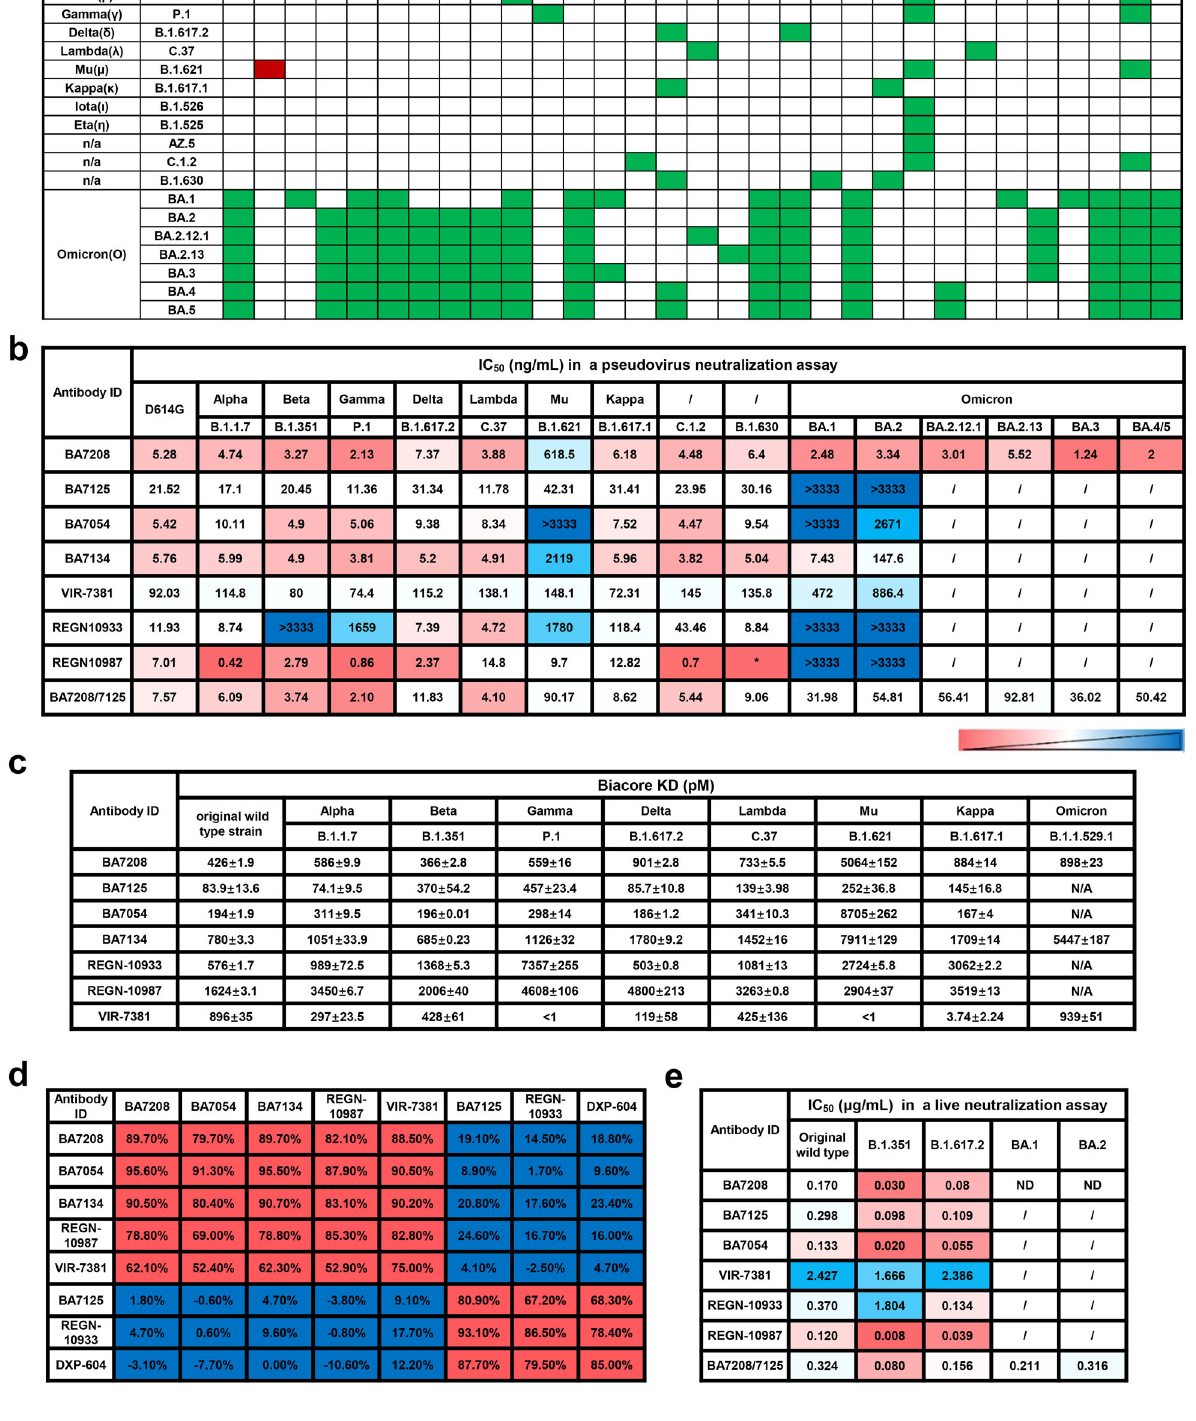
Fig. 2 (See legend on next